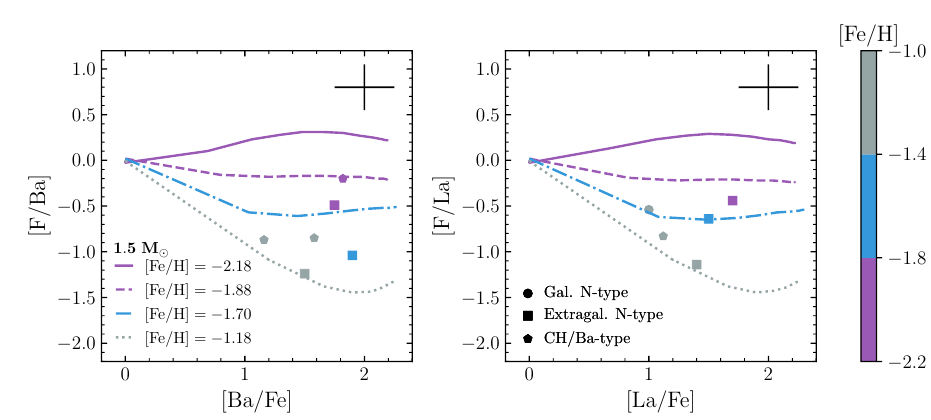
Figure 2. [F / Ba] vs. [Ba / Fe] (left panel) and [F / La] vs. [La / Fe] (right panel) in the sample stars with [Fe / H] ≤ − 1 . 0. Symbols as in Fig. 1. Note that at these low metallicities, theoretical AGB models predict that the star becomes C-rich from first TDU episodes. Data points and theoretical lines are color-coded by [Fe / H]. Typical error bars are